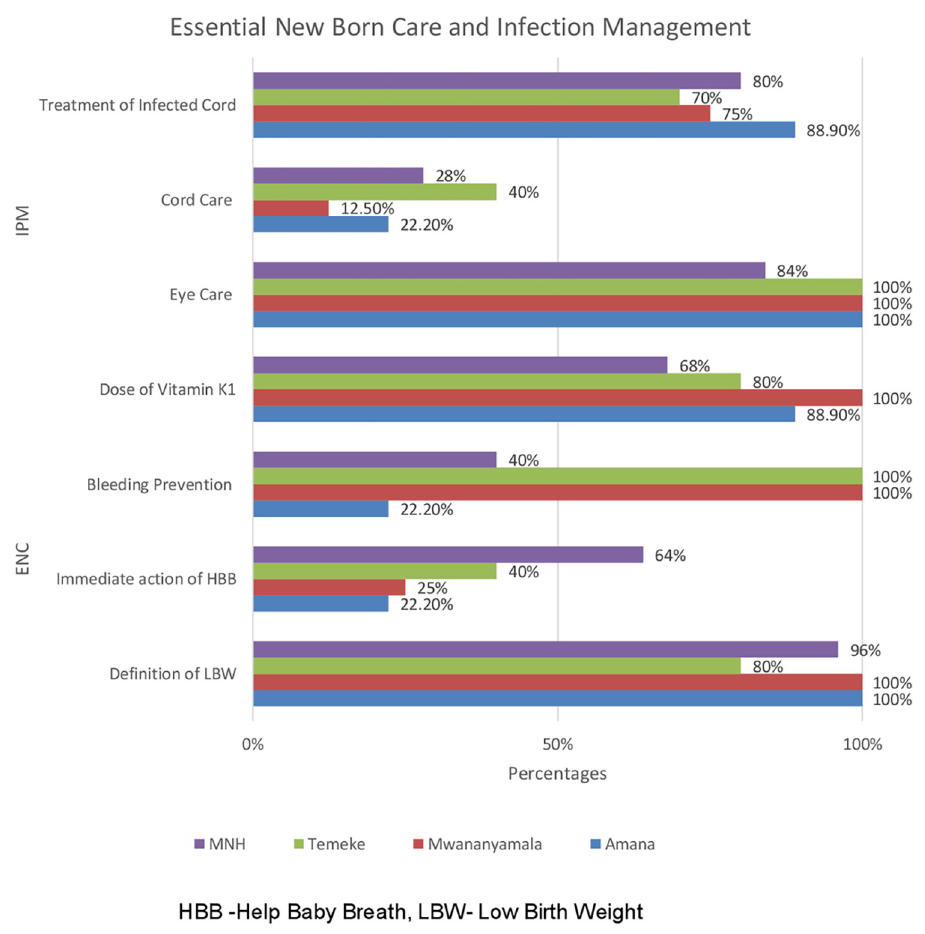
Fig 2. Nurses’ knowledge on Essential Newborn Care (ENC) and Infection Prevention and Management (IPM) domain by hospital.